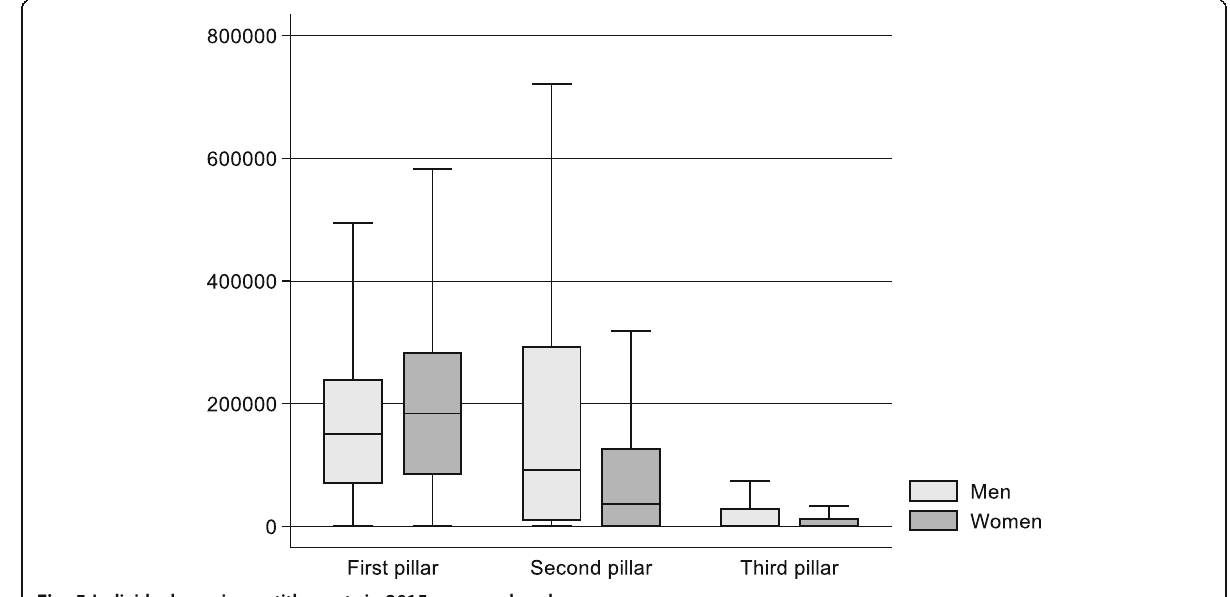
Fig. 5 Individual pension entitlements in 2015: mean values by sex Notes: individuals aged 18years and older ( n = 13,853); own calculations; survey weights applied. Source: linked data from SILC 2015 (experimental data for wealth from 7 June 2018) and administrative